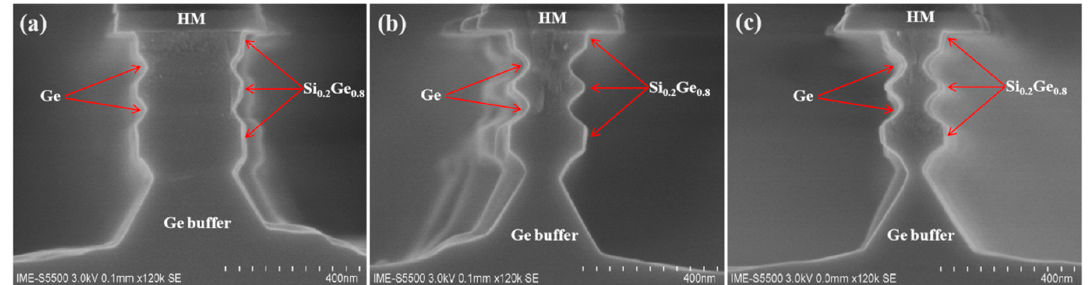
Figure 6. The SEM cross-section images of the Ge buffer/Si 0.2 Ge 0.8 /Ge stack structure after etching at different times in mixed solution HF/H 2 O 2 /CH 3 COOH (1:2:3): ( a ) etching for 2 s, ( b ) etching for 4 s, ( c ) etching for 6 s.